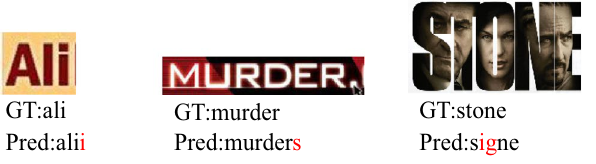
Fig. 5 Failure cases of base model. “GT” stands for ground-truth annotation, and “Pred” is the predicted result